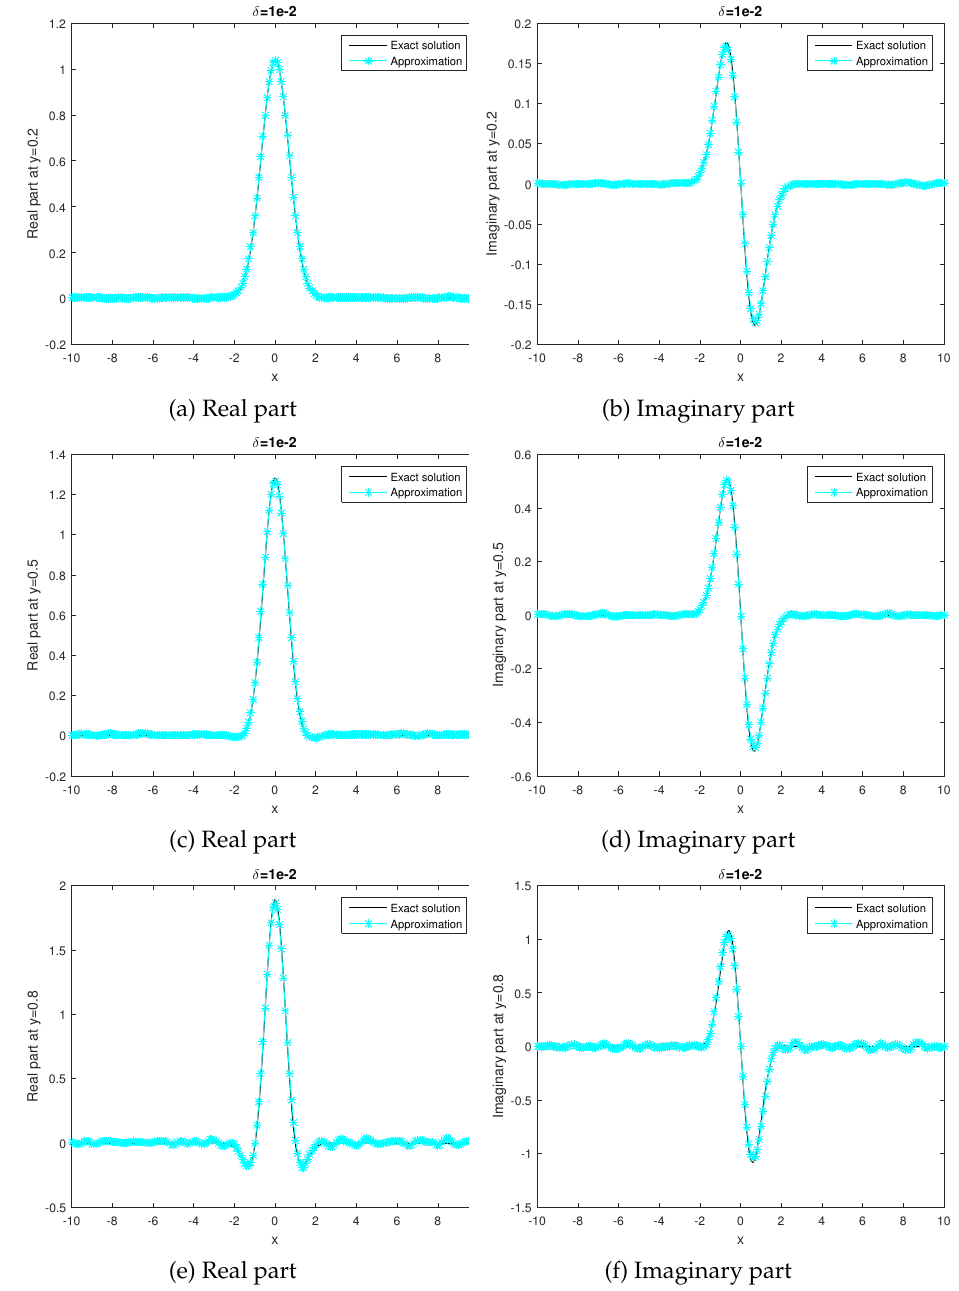
Figure 1. Example 4.1. Numerical results under the posteriori fractional Tikhonov method. Figure 1. Example 1. Numerical results under the posteriori fractional Tikhonov method. ( a , b ) are (a) and (b) are real part and imaginary part at y = 0.2, respectively, where µ = 1 e real part and imaginary part at y = 0.2, respectively, where µ = 1 (c) and (d) are real part and imaginary part at y = 0.5, respectively, where µ = 1 e imaginary part at y = 0.5, respectively, where µ = 1 (e) and (f) are real part and imaginary part at y = 0.8, respectively,where µ = 1 e y = 0.8, respectively, where µ = 1